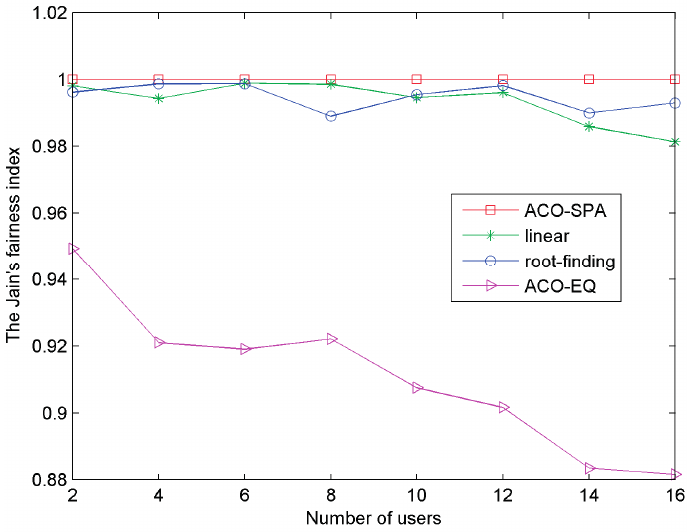
Figure 9. The Jain’s fairness index of system versus the number of